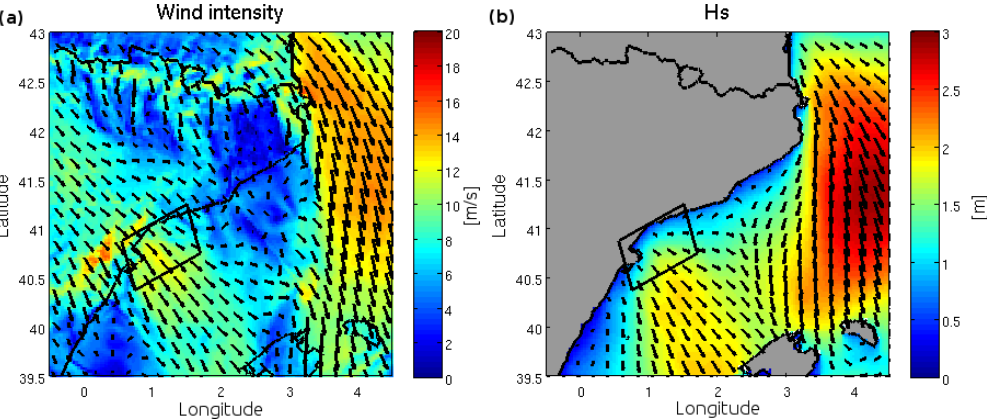
Figure 16. Results of the second-level domain on 25 April at 12:00. ( a ) Wind intensity. ( b ) Significant wave height and wave direction. The black rectangle corresponds to the local